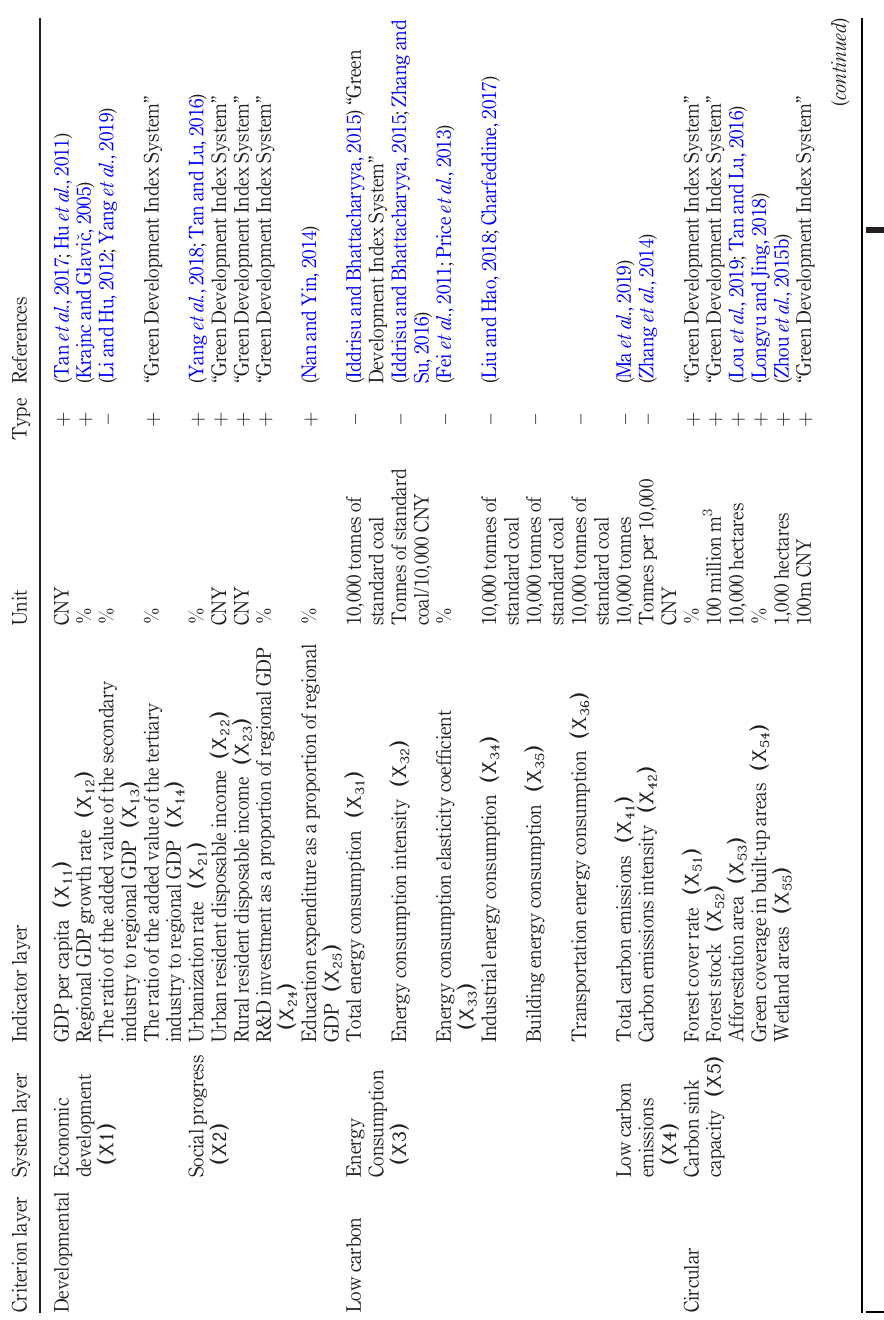
Table 1. Evaluation